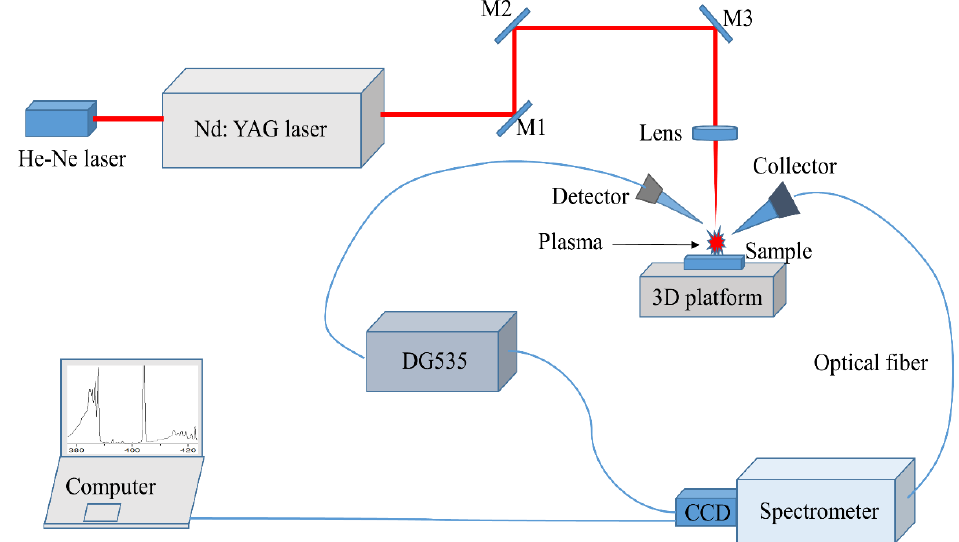
Figure 1. A schematic of the LIBS experimental setup for penicillin sample